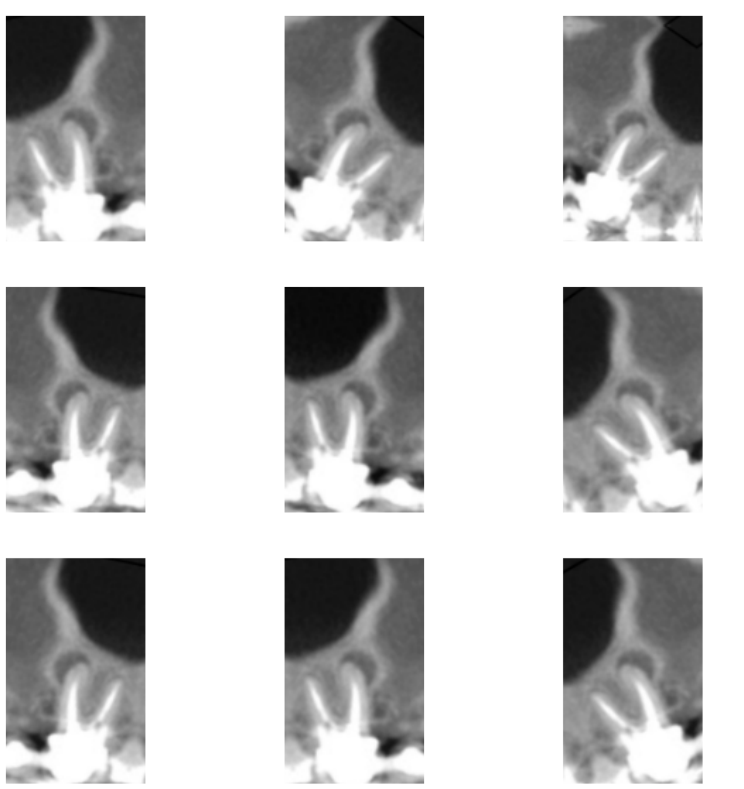
Figure 4. Image of Figure 2e subjected to nine different combinations with the three data augmenta- tion techniques used in this